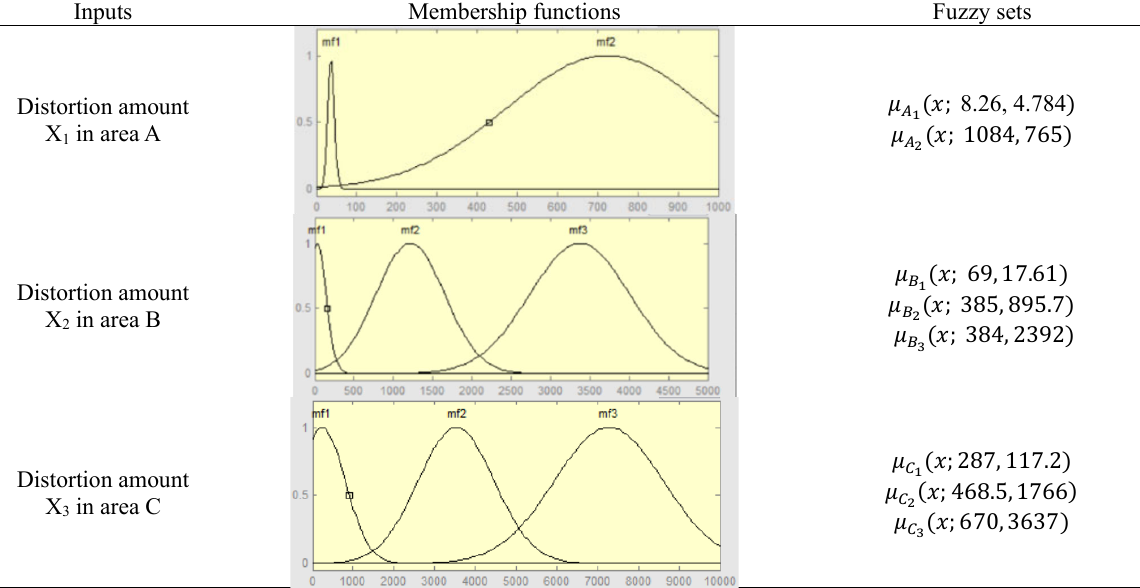
The membership functions and fuzzy sets for the inputs